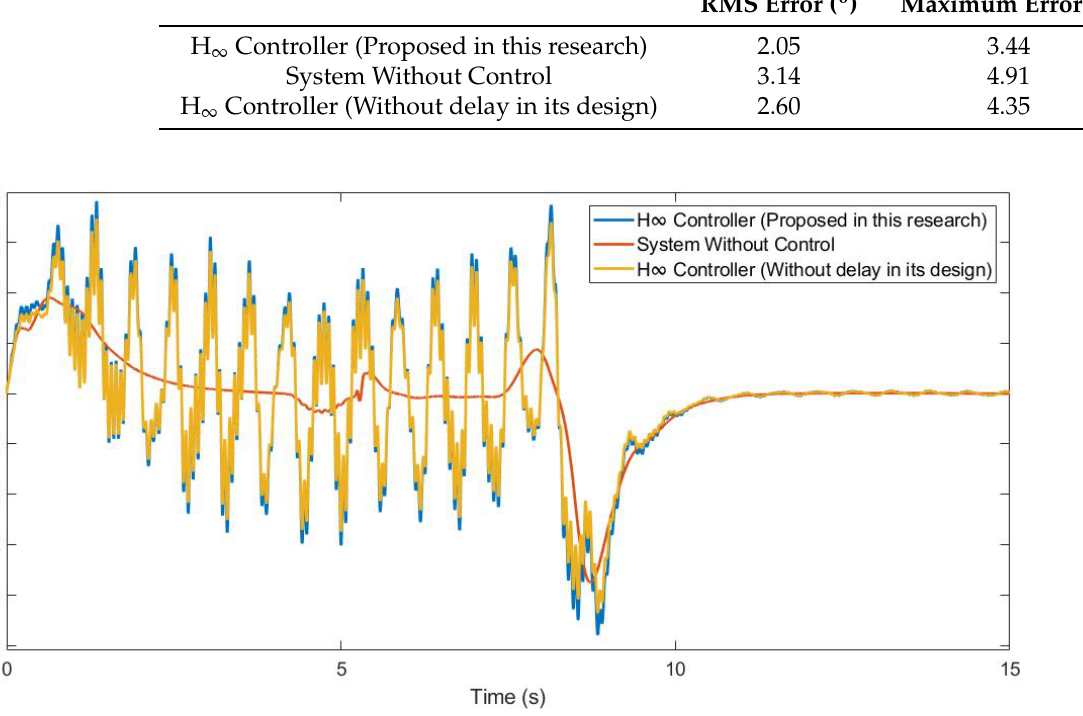
Figure 10. Roll rate for test 1: Roundabout at 30